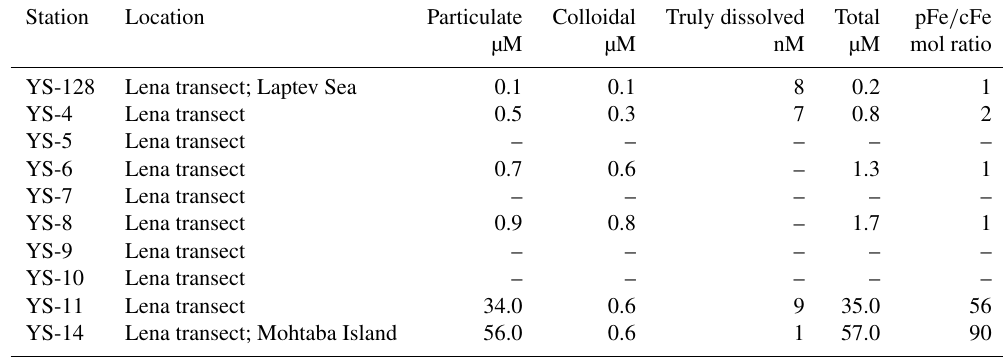
Table 3. Iron concentrations of the different fractions for the Lena River freshwater plume. Station Location Particulate Colloidal Truly dissolved